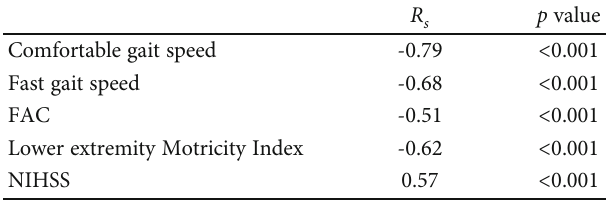
Table 2: Concurrent and convergent validity of Thai G.A.I.T. scale.